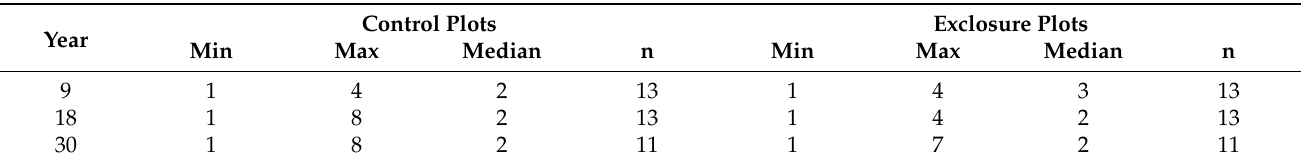
Table 6. Descriptive statistics (min, max, median) of species richness (number of shrub species detected) within the control and exclosure plots throughout the 30-year study